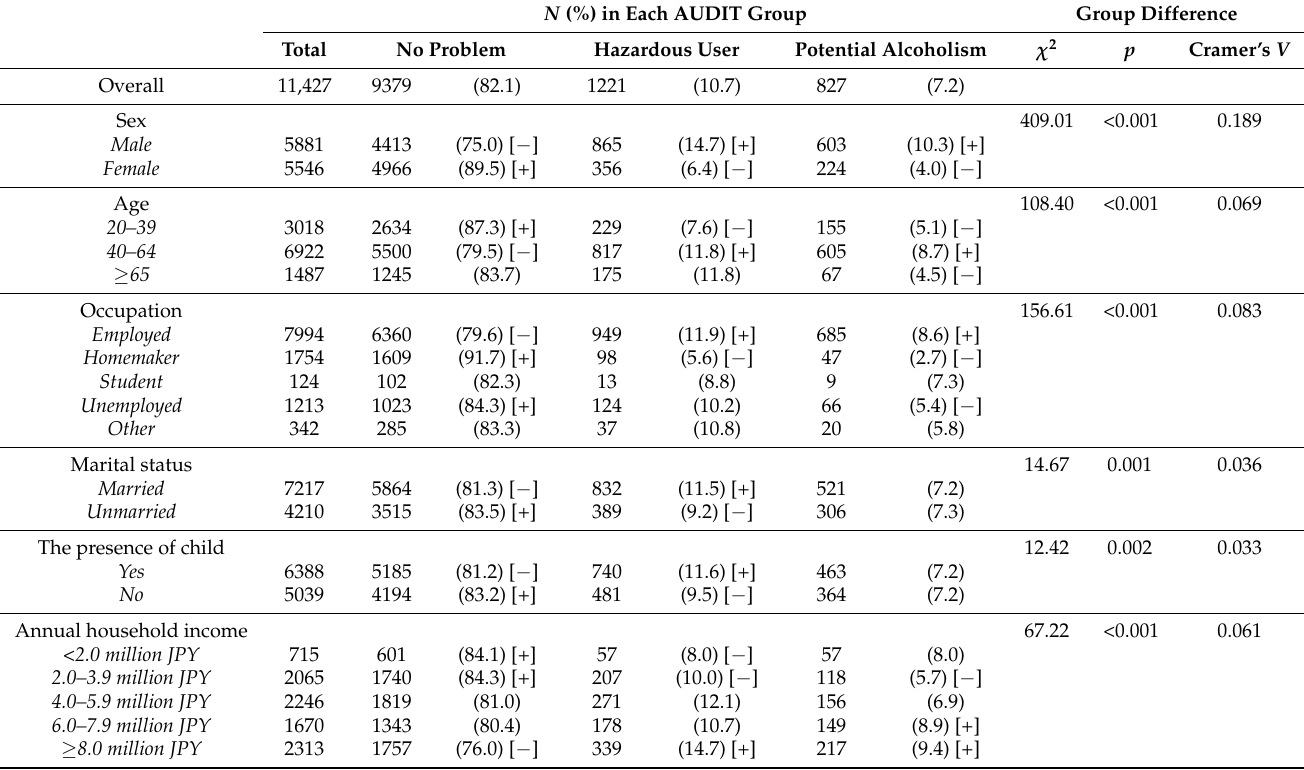
Table 2. Comparisons of sociodemographic data between three AUDIT group.